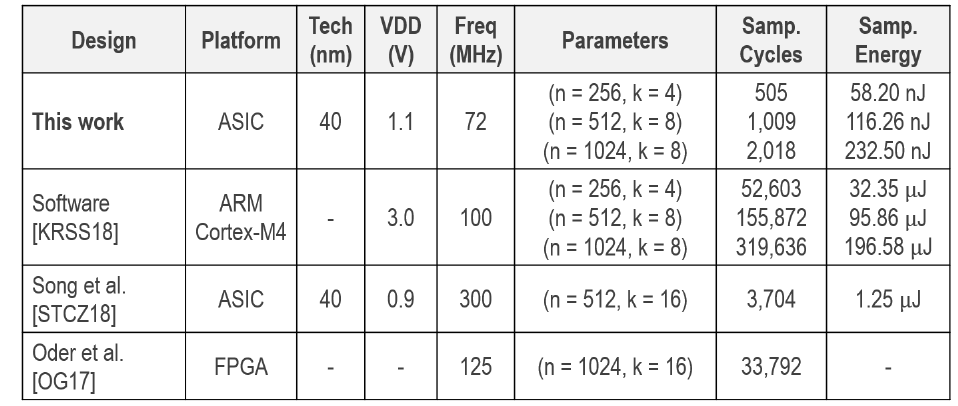
Table 5: Comparison of binomial sampling with